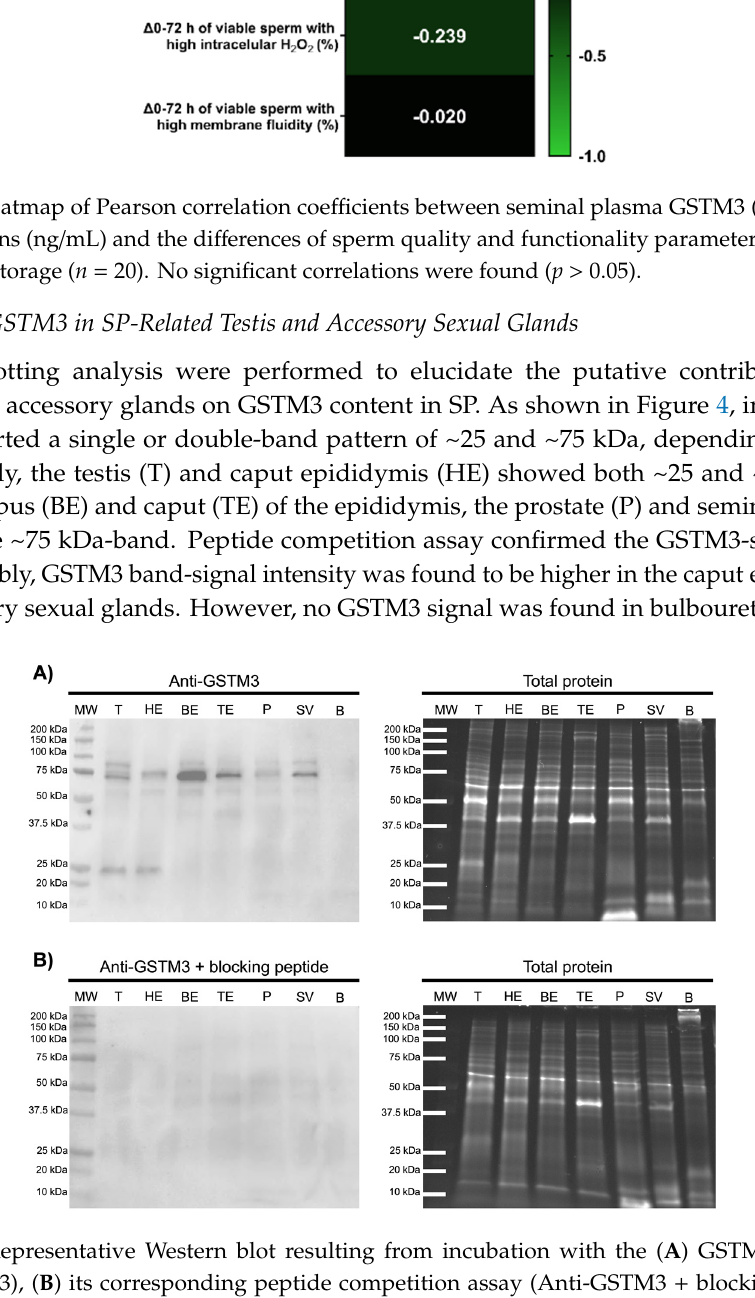
Figure 3. Heatmap of Pearson correlation coefficients between seminal plasma GSTM3 (SP-GSTM3) concentrations (ng/mL) and the differences of sperm quality and functionality parameters between 0 and 72 h of storage ( n = 20). No significant correlations were found ( p > 0.05).